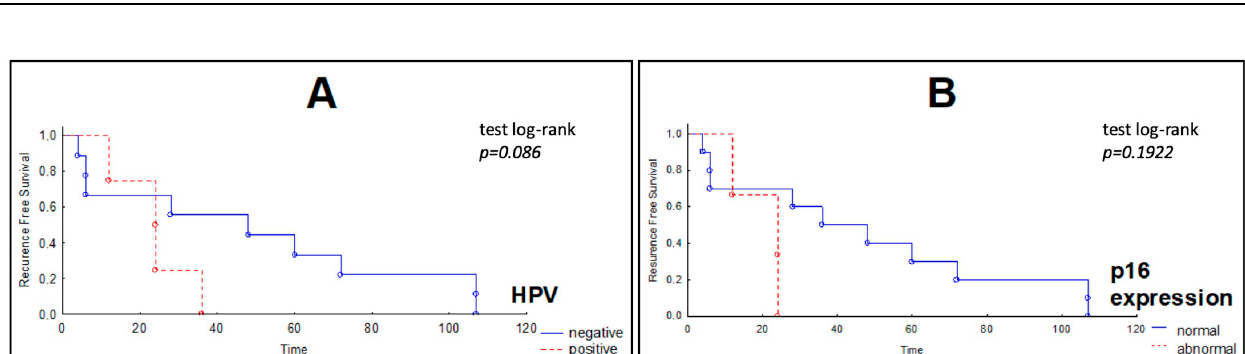
Figure 2. Kaplan − Meier curves of recurrence-free survival (RFS) of HNSCC patients according to ( A ) HPV infections and ( B ) p16 expression. Patients with p16 abnormal expression in tumors show a worse outcome (the X axis—the survival time in months, Y axis—the RFS).